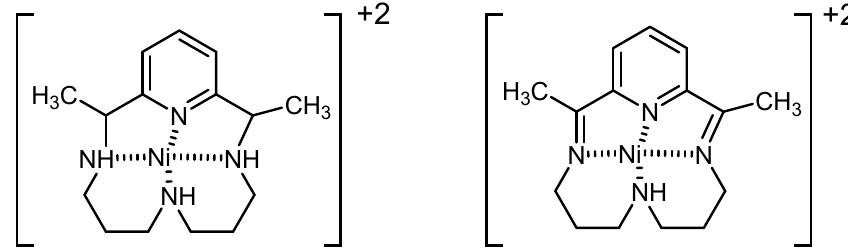
Figure 2. The structures of Ni(II) complexes catalytically active for HDH of polychlorinated ben- zenes [65,66].